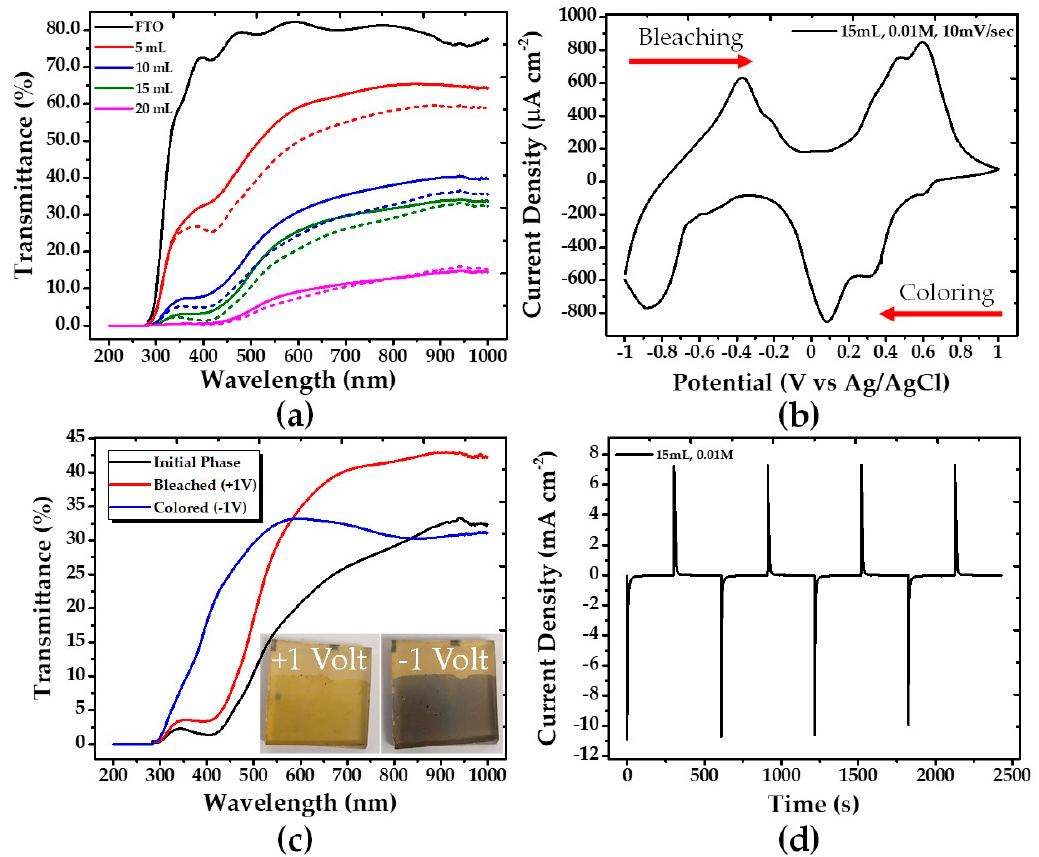
Figure 6. ( a ) UV–VIS transmittance comparison of the samples before (solid lines) and after (dashed lines) annealing; ( b ) Cyclic voltammogram after annealing of 15 mL sample; ( c ) UV–VIS transmittance comparison of the initial, bleached, and colored state of the 15 mL V 2 O 5 coating; and ( d ) Chronoamperometry after annealing of 15 mL sample.